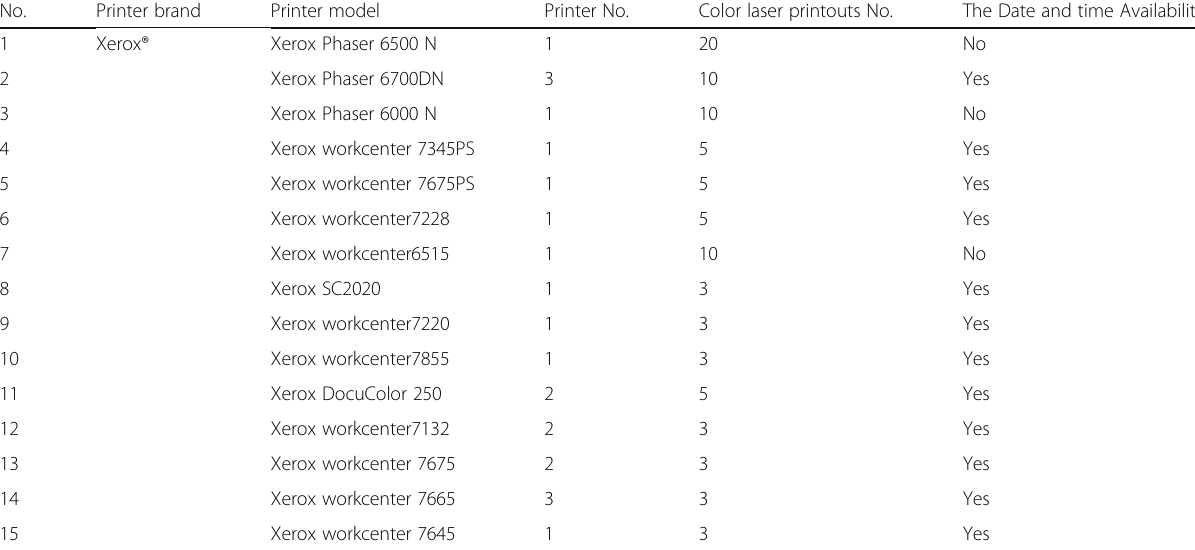
Table 1 The color laser printer models of Xerox® brand used in our study No. Printer brand Printer model Printer No. Color laser printouts